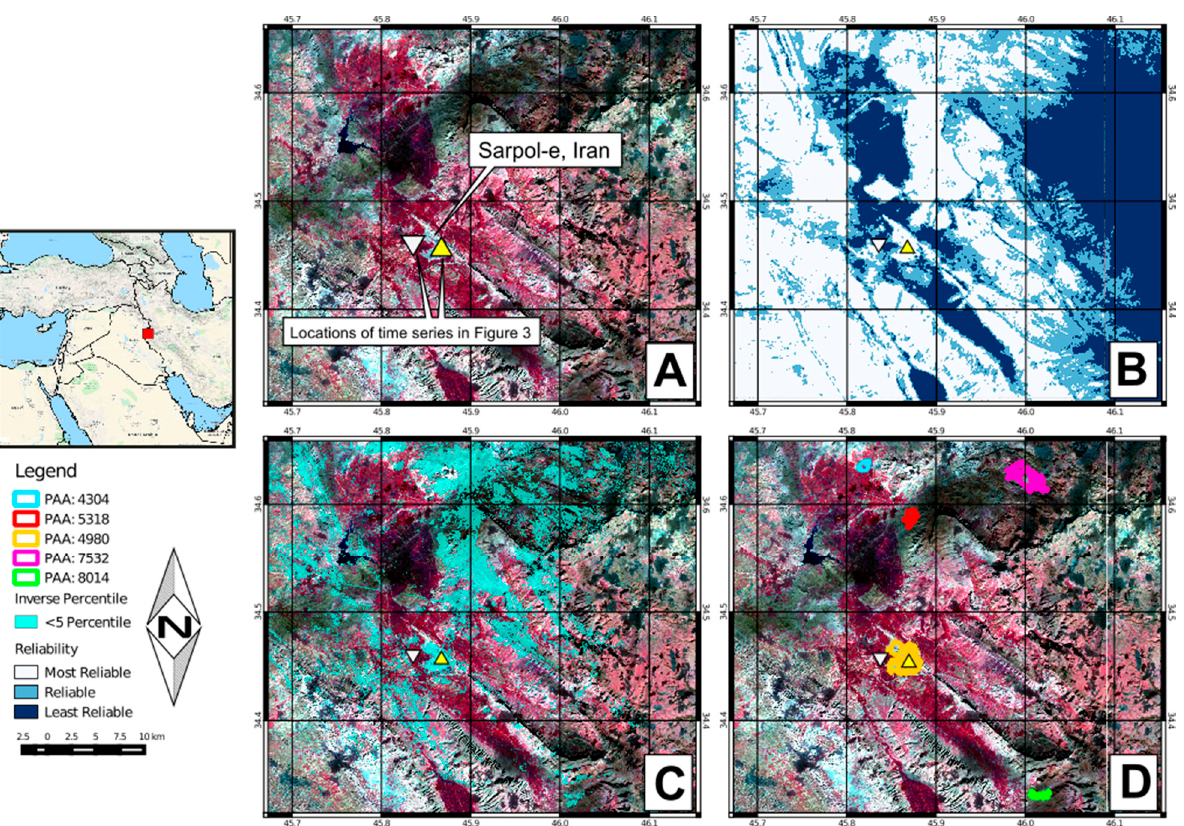
Figure 2. Results of the PAA-detection algorithm following the 12 November 2017 earthquake near Sarpol-e, Iran. ( A ) False-colour Sentinel-2 composite (R = Near Infrared, G = Red, B = Green) of the region, highlighting the presence of agricultural fields outside of the city of Sarpol-e (shown in red in the false colour composite). Location of coherence time series shown in Figure 3A is denoted by a yellow triangle and Figure 3B. by a white triangle; ( B ) Reliability map of the Sarpol-e region, based on the variability of coherence data in the year preceding the earthquake. Note that the vegetated agricultural fields visible in ( A ) are classified as “least reliable” due to the high noise associated with vegetated surfaces using C-band radar; ( C ) All regions (shown in blue) where the coherence of the pre- and post-event pair were less than the 5th percentile of the annual coherence distribution, before connected components and filtering are performed; ( D ) The five largest, most populous PAAs detected in relation to the 12 November 2017 earthquake (cf. Table 2). Inset map data: Google Maps.